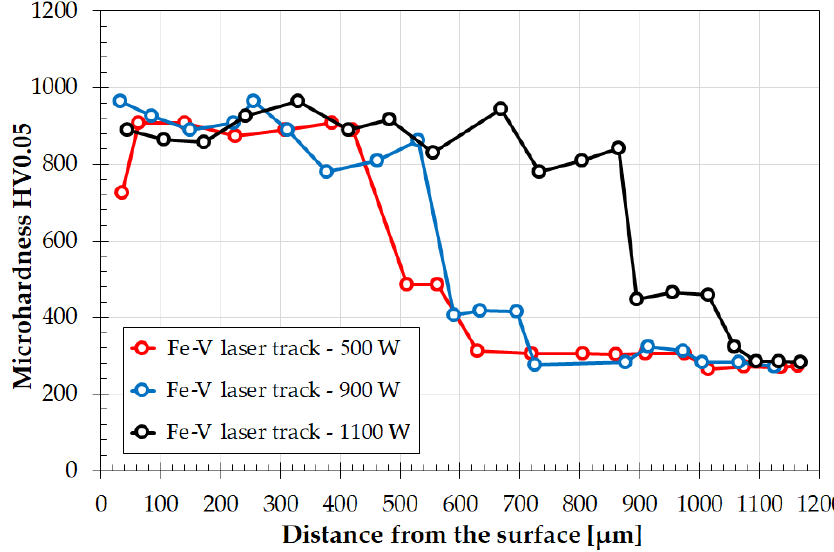
Figure 5. Microhardness profiles of single laser tracks for coatings produced using various laser beam powers: 500 W, 900 W, and 1100